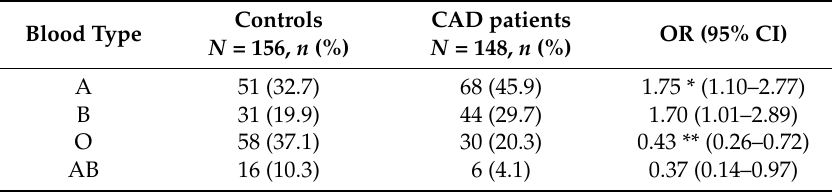
Table 5. Frequencies of ABO blood types among CAD patients and